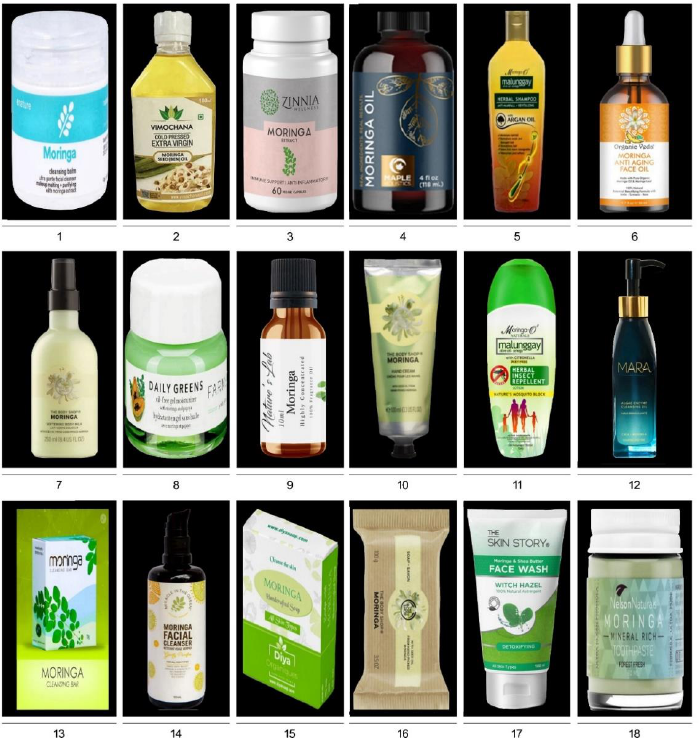
Figure 5. Moringa commercial non-food products. Details of products 1 – 18 are listed in Table 5. Table 4. Commercial details of Moringa functional food products.